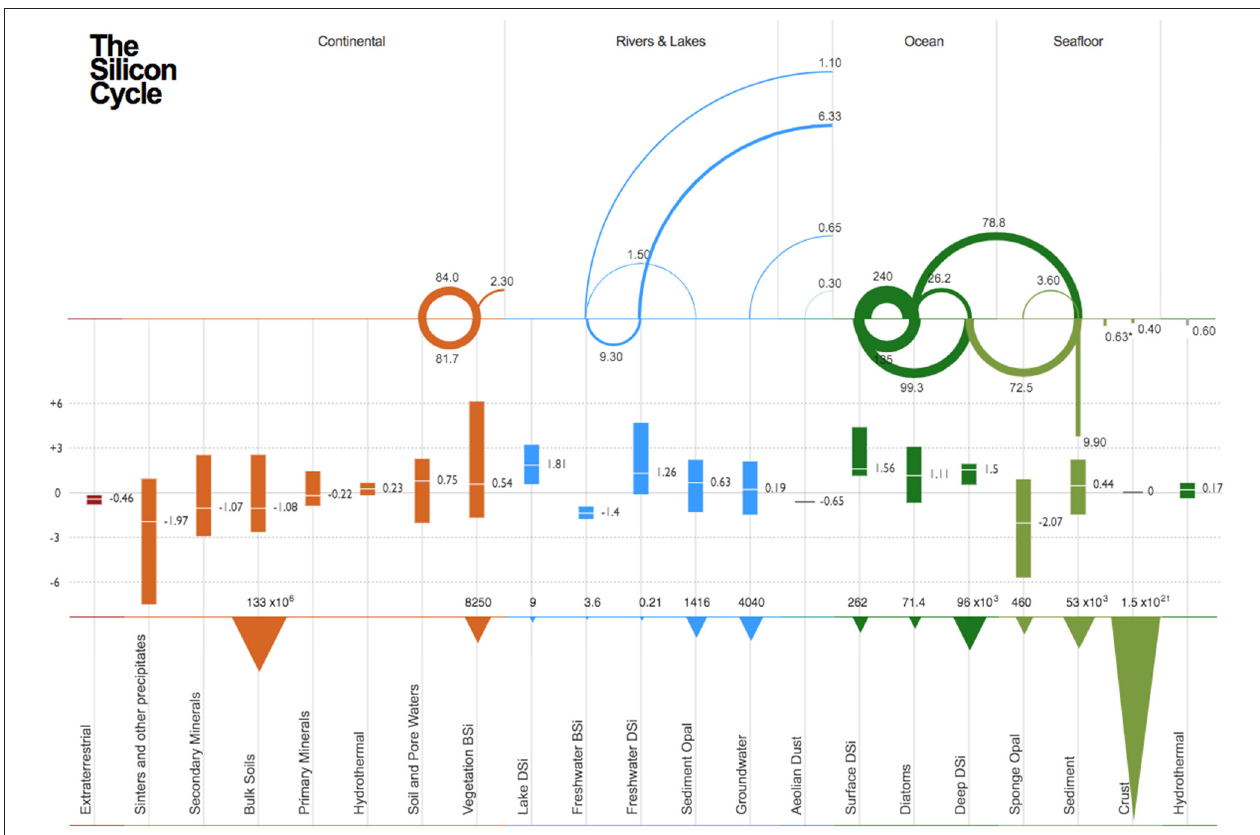
FIGURE 1 | Schematic of the modern day global Si cycle grouped by reservoir and their associated δ 30 Si values (in ‰ ). The figure is divided into three parts. The upper part indicating the magnitude of the fluxes (in 10 12 mol yr − 1 ; Tmol yr − 1 ) between each reservoir, the middle part showing their associated δ 30 Si values, and the lower part showing reservoir size. The fluxes are numerically and figuratively represented, moving in a clockwise manner (e.g., In the Ocean compartment, there is a flux of 240 Tmol yr − 1 from Surface DSi to Diatoms, after the Diatoms dissolve, there is 135 Tmol yr − 1 flux back from the Diatoms to the Surface DSi in the upper water column). In the case where the flux points downwards (e.g., 9.90 Tmol yr − 1 within the sediment reservoir), the flux is effectively removed from the system. * Value assumed to underestimate flux (see section Diagenetic Silica Precipitation and Reverse Weathering). Estimates for the Si fluxes were obtained from the